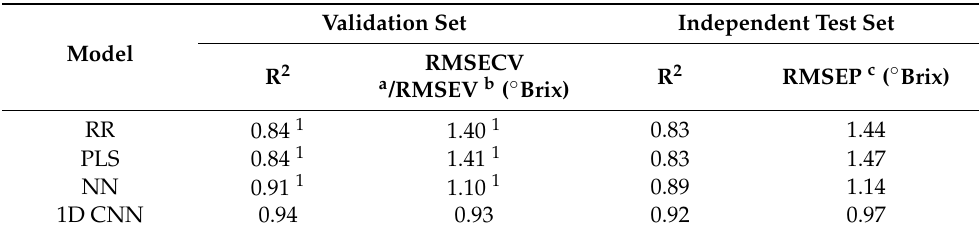
Table 4. Results obtained by the four classes of machine learning methods for validation and test sets, using the Touriga Franca variety.